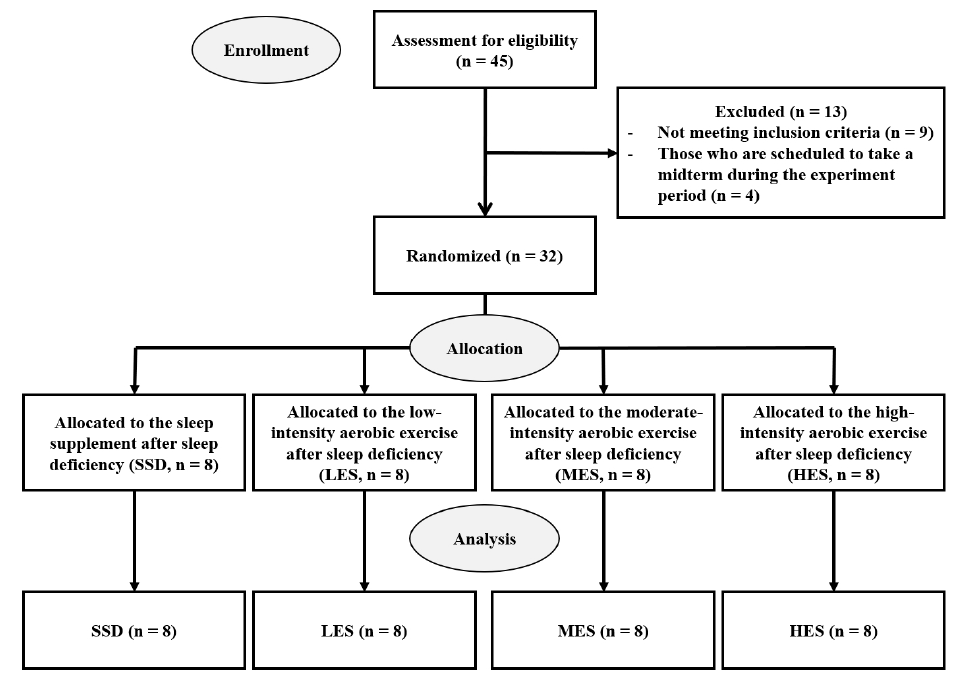
Figure 1. Flow chart.